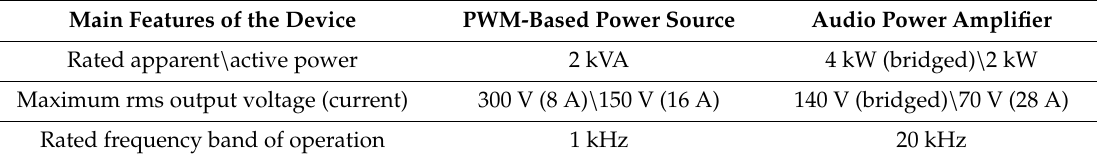
Table 1. Summary of specifications of both power